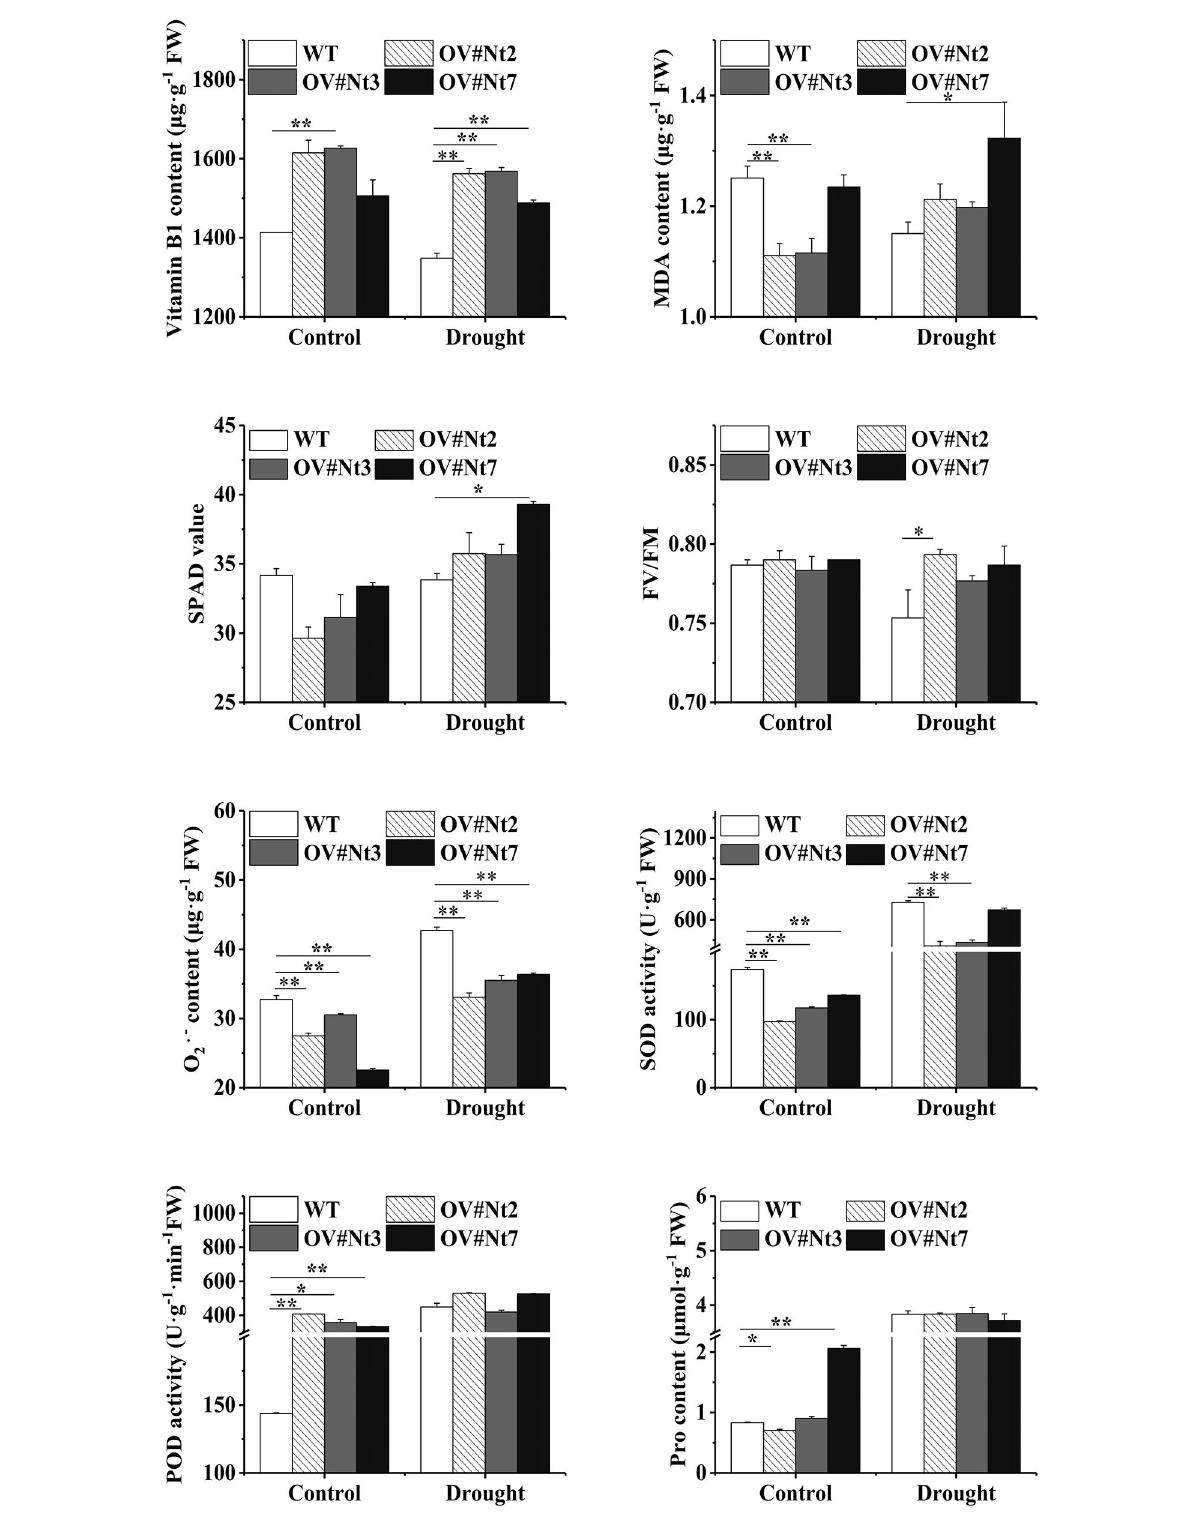
FIGURE4 Modifications in the physiology of transgenic tobacco plants that overexpress MsTHI1 during control or under drought stress. Mean ± standard deviations from three biological replicates are displayed with error bars. MDA, malondialdehyde. SPAD, soil and plant analyzer